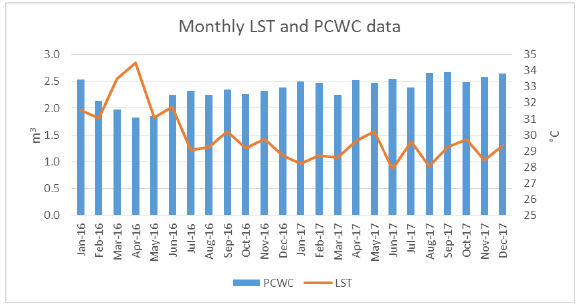
Figure 11. Monthly LST derived from MODIS and computed monthly PCWC data for the entire 49 barangays However, same month of April 2016 tallied the lowest water consumption with a computed PCWC of 1.83 m 3 or 1,830 liters compared to the 2016-17 monthly average of 2.36 m 3 or 2,360 liters, while the highest PCWC was 2.67 m 3 of September 2017. Figure 11 revealed that monthly PCWC was moderately contrasting with the monthly mean LST values. This was evident as the correlation between the monthly LST and PCWC produced a negative value. The acquired R of -0.71, p <0.01, and an R 2 of 0.5085 (Figure 12), means that when the LST rises, the PCWC data decreases or the other way around.